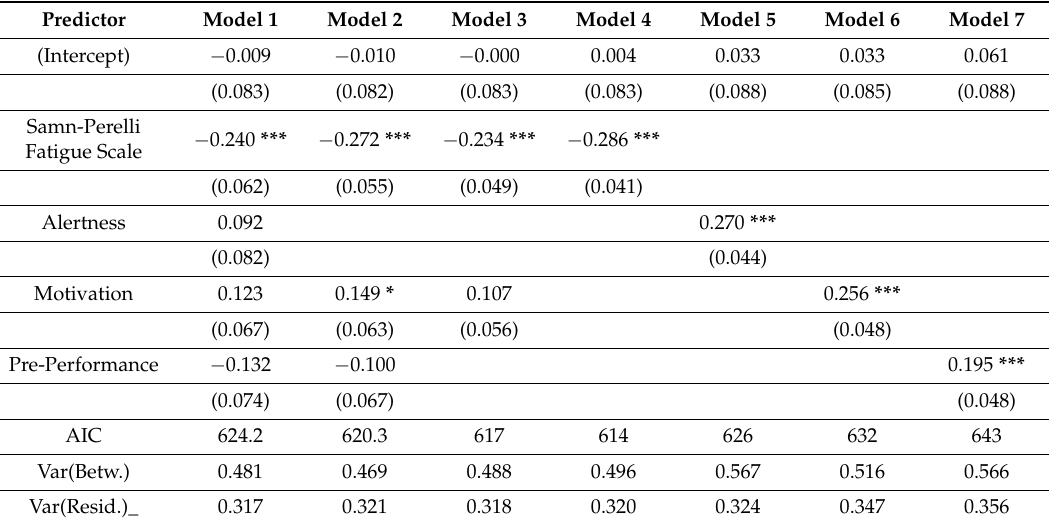
Table 3. Correspondence between measures of subjective fatigue and